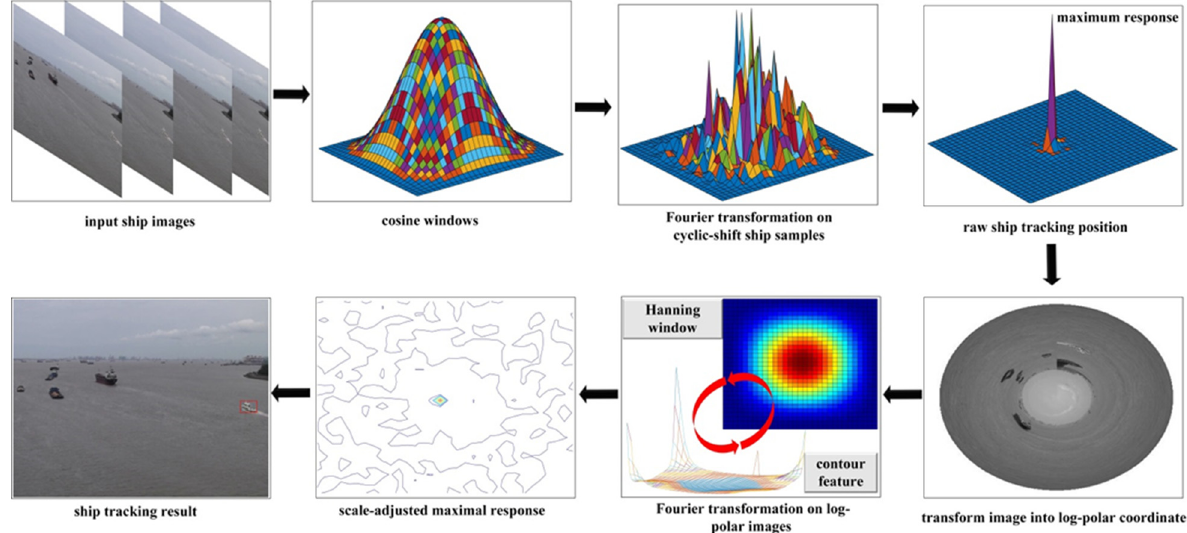
Figure 2. Working flow for the proposed scale-adaptive kernelized correlation filter.